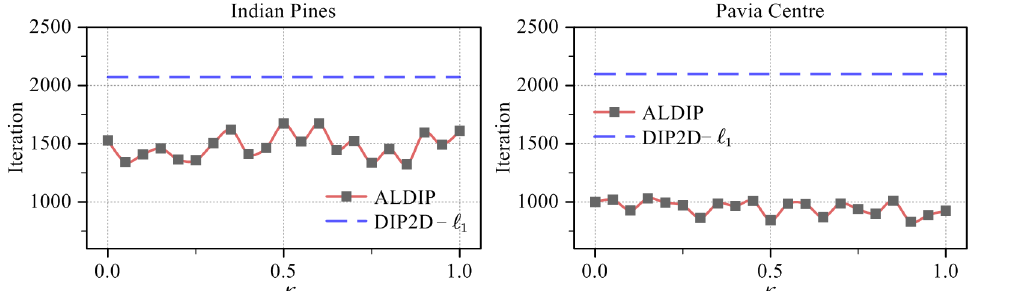
Figure 12. The trend of iterations to reach the best PSNR changing with the initial value of κ on Indian Pines (case 8) and Pavia Centre (case 12).